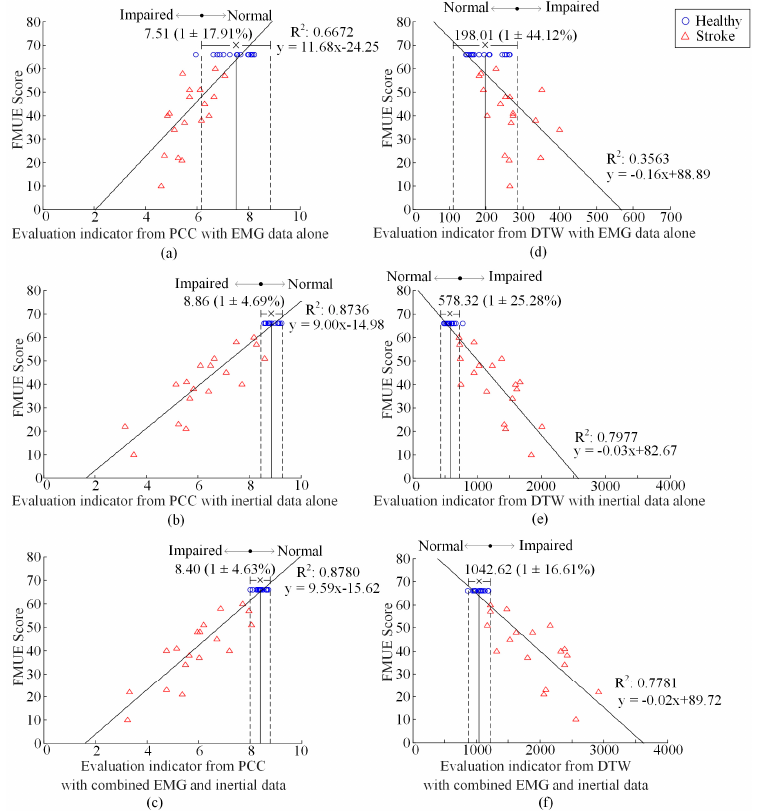
Figure 5. Plot of FMUE score versus the global EI, from PCC ( a – c ) and DTW ( d – f ) with EMG data alone ( a , d ), inertial data alone ( b , e ) and combined data ( c , f ), respectively. R 2 reports the coefficient of determination from the linear regression analysis. The ‘×’ and the bar denote the mean and 1.96-times SD of the healthy subjects’ EI. The range between the two dashed lines over the horizontal axis represents the normal range. Circles and triangles represent data from individual healthy and stroke subjects, respectively.